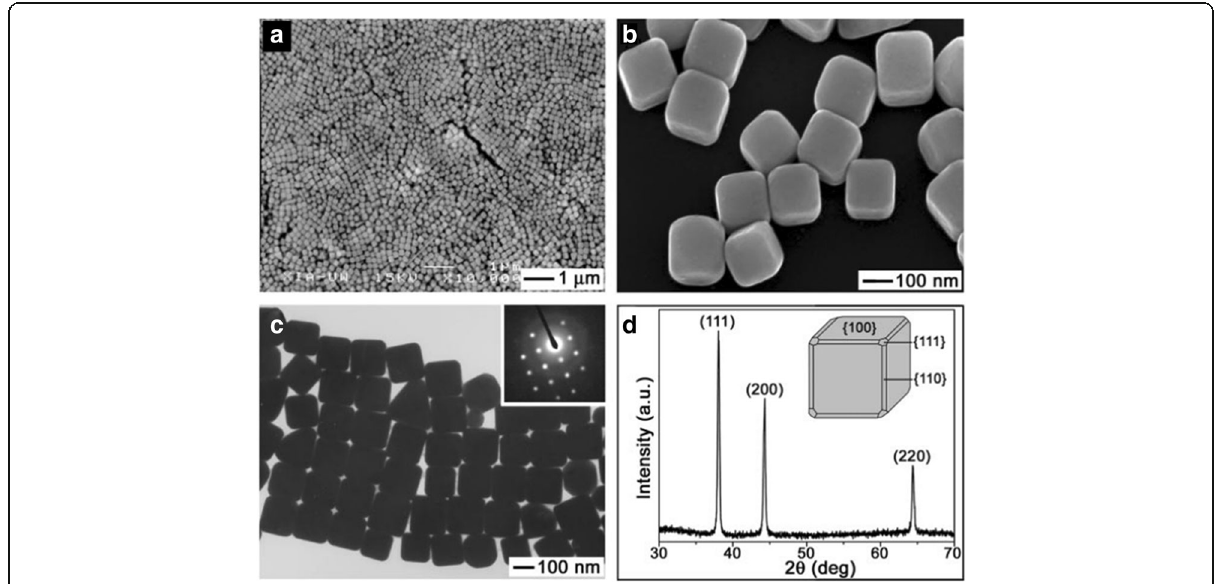
Fig. 1 a Low- and b high-magnification SEM images of slightly truncated silver nanocubes. c A TEM image of the same batch of silver nanocubes. d An XRD pattern of the same batch of sample, confirming the formation of pure fcc silver